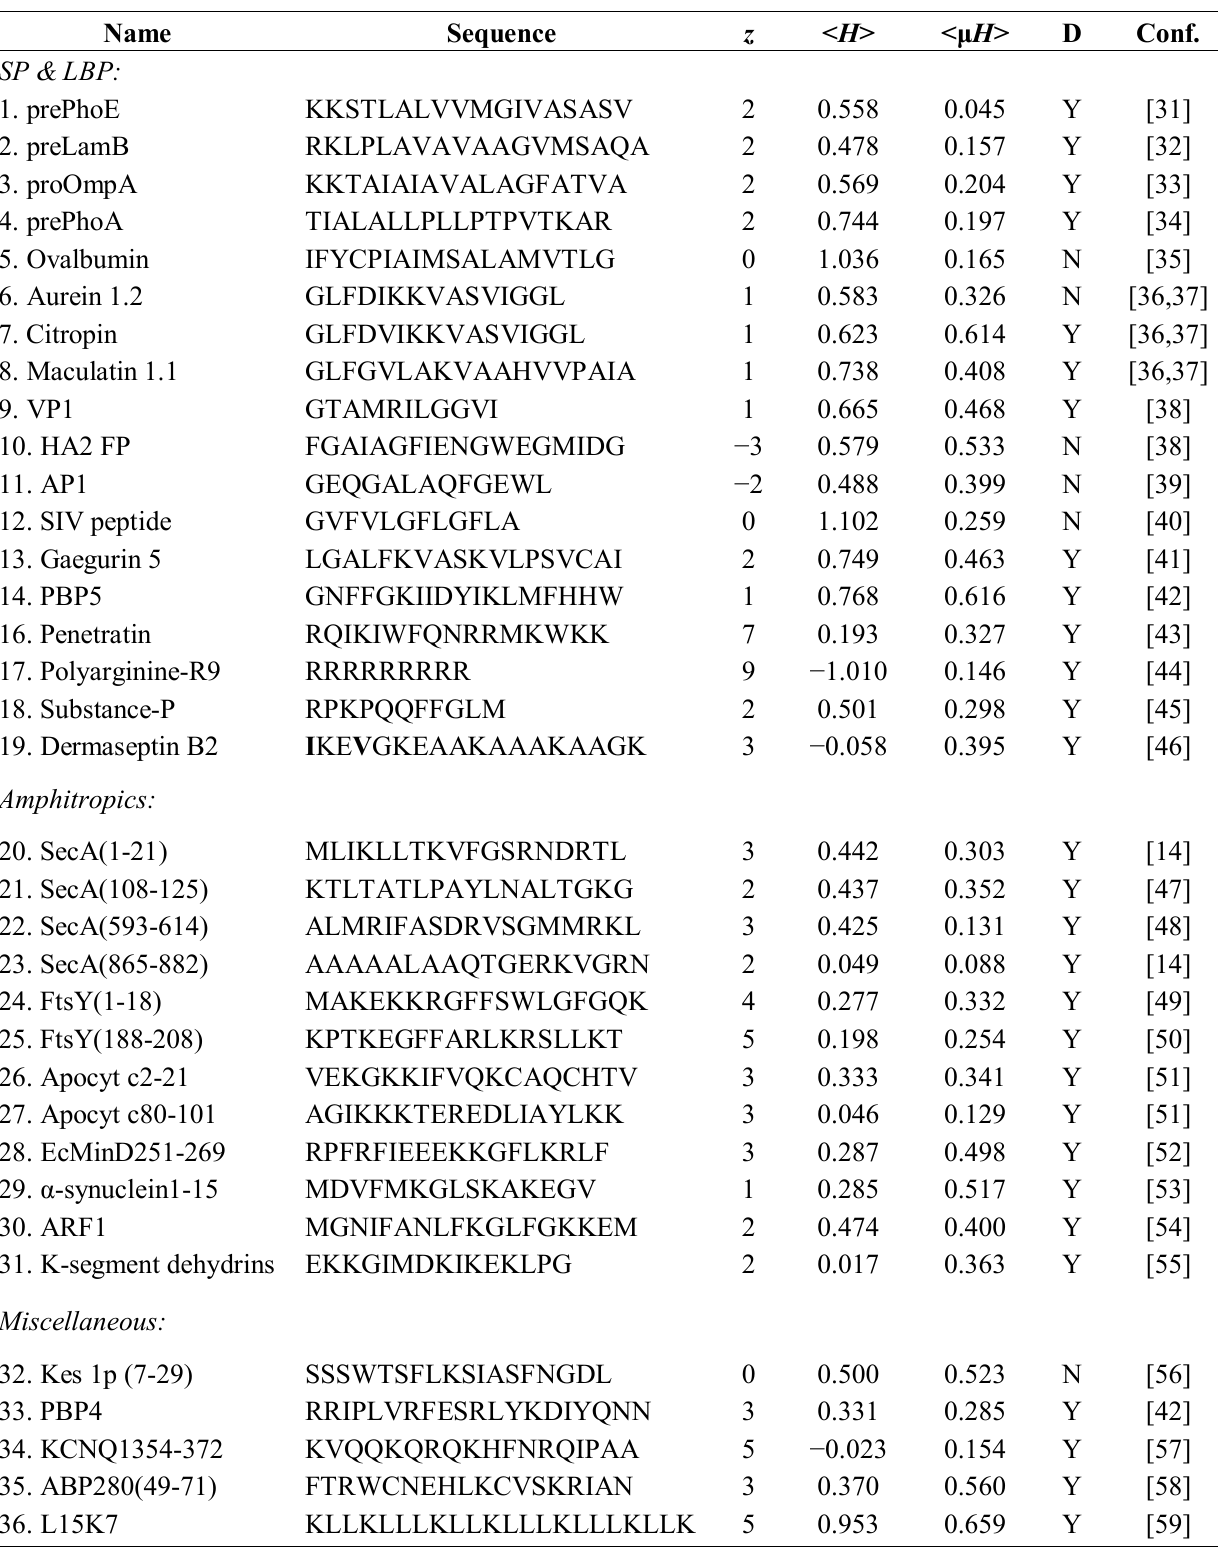
Table 2. Examples of demonstrated lipid-binding proteins and peptides, which are not always identified by the Eisenberg plot methodology. The results of using the lipid-binding discrimination factor of the Heliquest program are